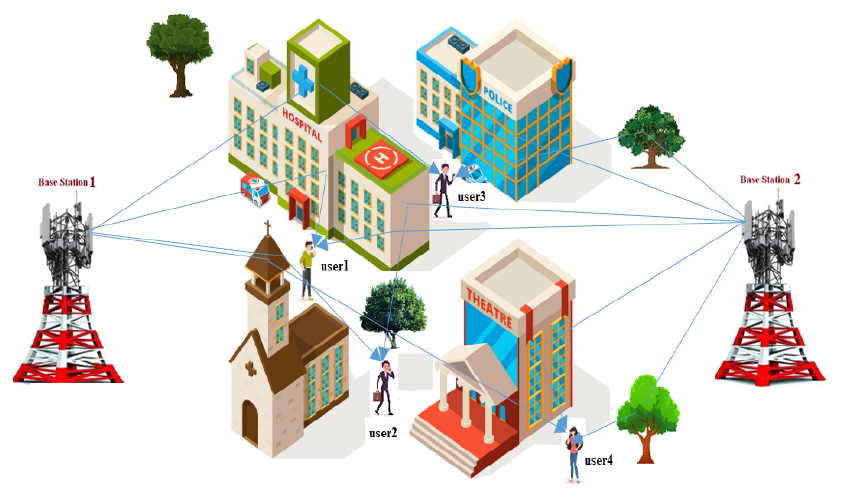
Figure 2. A scenario of CoMP-JT-based mmWave signal transmission from two BSs to four